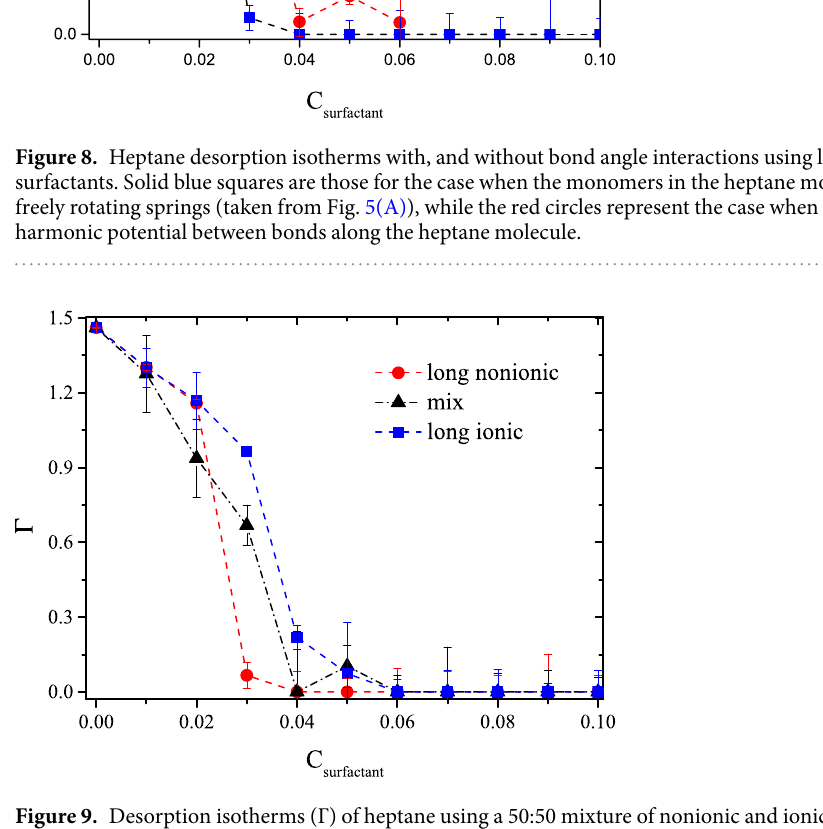
of long, ionic and nonionic surfactants under the same conditions as in the previous simulations. By carrying out simulations at increasing concentration of the mixture of surfactants, we calculated the heptane desorption isotherm, and compared it with those obtained for the pure nonionic and pure ionic surfactant cases. The results can be found in Fig. 9. Figure 9 shows that adding a 50:50 mixture of long ionic and nonionic surfactants to the fluid made up of heptane adsorbed on surfaces and the solvent, does reduce the concentration of long ionic surfactants needed to desorb the HC completely by about twenty percent with respect with the pure ionic surfactant case, but it also creates fluctuations in the concentration of nonionic surfactants needed for complete desorption. This means that the addition of electrically charged molecules to the neutral system reduces the efficiency of the long nonionic surfactants to encapsulate the HC molecules due to the electrostatic repulsion between the ionic surfactant heads. Therefore, it appears to be unnecessary to use nonionic/ionic surfactant mixtures to desorb more effectively HC molecules. Lastly, and considering that EOR is a procedure that is performed under flow, we study the influence of the strength of the external flow imposed on the fluid. All results presented so far correspond to a constant value of the external force that creates Poiseuille flow along the x – direction, in particular, F ext ( x ) = α f with α f = 0.0075 in reduced DPD units. In Fig. 10A, we show the comparison between three Poiseuille flow conditions focusing